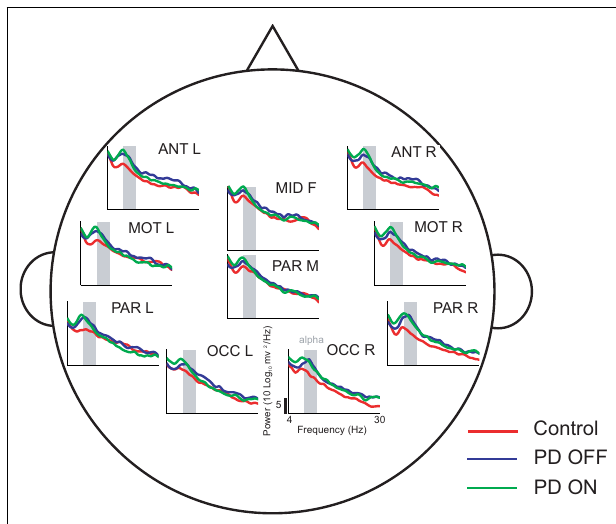
FIGURE 6 | Power spectral density estimates across all ten clusters using 50 1-s trials . In comparison to controls, PD patients off medications demonstrate increased theta activity at a few cluster locations, such as the anterior clusters (ANT L and ANT R)